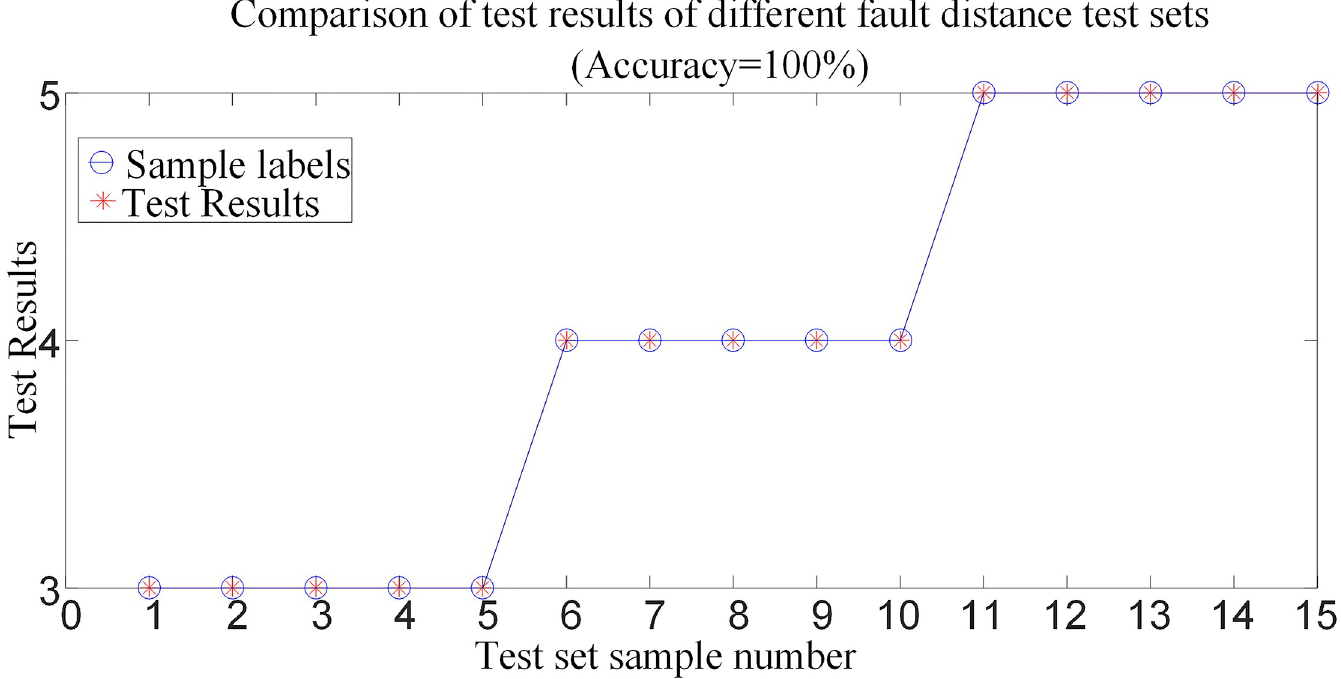
Fig 16. Comparison of test results when faults occur at different distances.